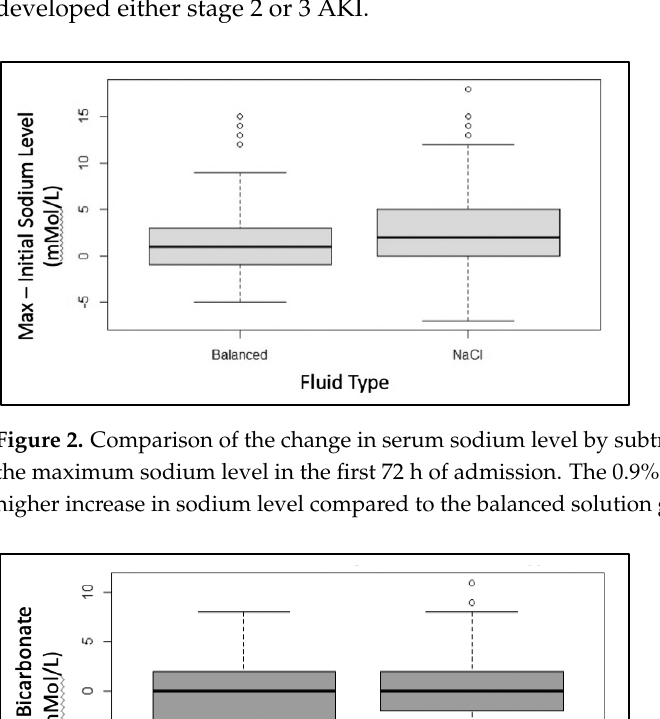
Table 2. Multivariable Logistic Regression Analysis for the Development of Acute Kidney Injury Figure 3. Comparison of the change in serum bicarbonate level by subtracting the minimum bicar- (AKI). There was no association between maintenance fluid therapy choice and AKI. (OR: odds, ratio, bonate level from the initial bicarbonate level in the first 72 h of admission. There was no difference PELOD-2: Pediatric Logistic Organ in the decrease in bicarbonate levels between the two groups, p = 0.830.